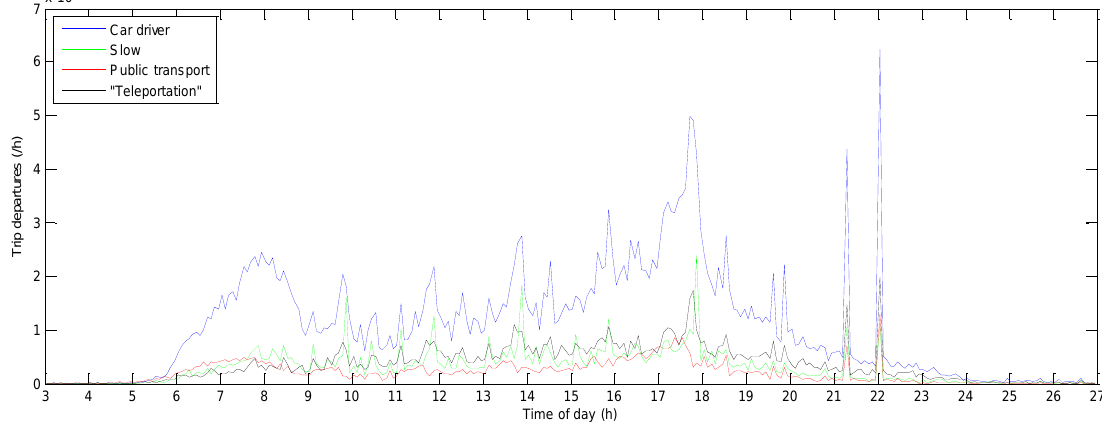
Figure 5. Trip departures per mode in Albatross activity-travel patterns for the case study The next step is to perform route choices for the activity-travel patterns of Albatross. Let denote the disutility of route r , as in Equation 2, using the travel times resulting from iteration i . r then indicate the chosen route in iteration i , based on the travel times resulting Let i